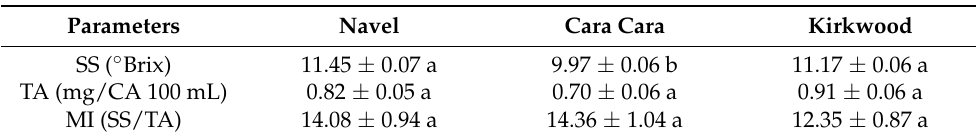
Table 1. Soluble solids (SS), titratable acidity (TA) maturity index (MI) of Navel, Cara Cara, and Kirkwood